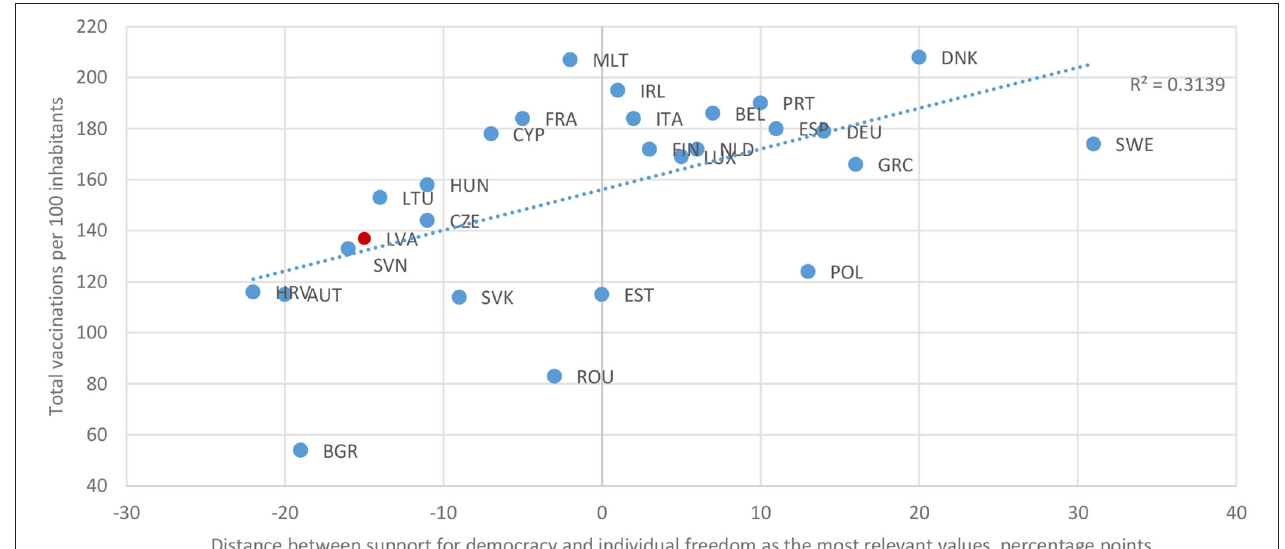
FIGURE 6 | Correlation between people’s attitude toward democracy* and the speed of vaccination** in EU member states (13, 14). Notes: (*) The ranking of EU member states is based on the difference between the share of those opinion poll respondents who chose “democracy” and those who chose “individual freedom” as the most important value for them personally: the more negative the difference, the bigger the share of respondents preferring individual freedom over democracy. (**) Vaccination data on 30 December